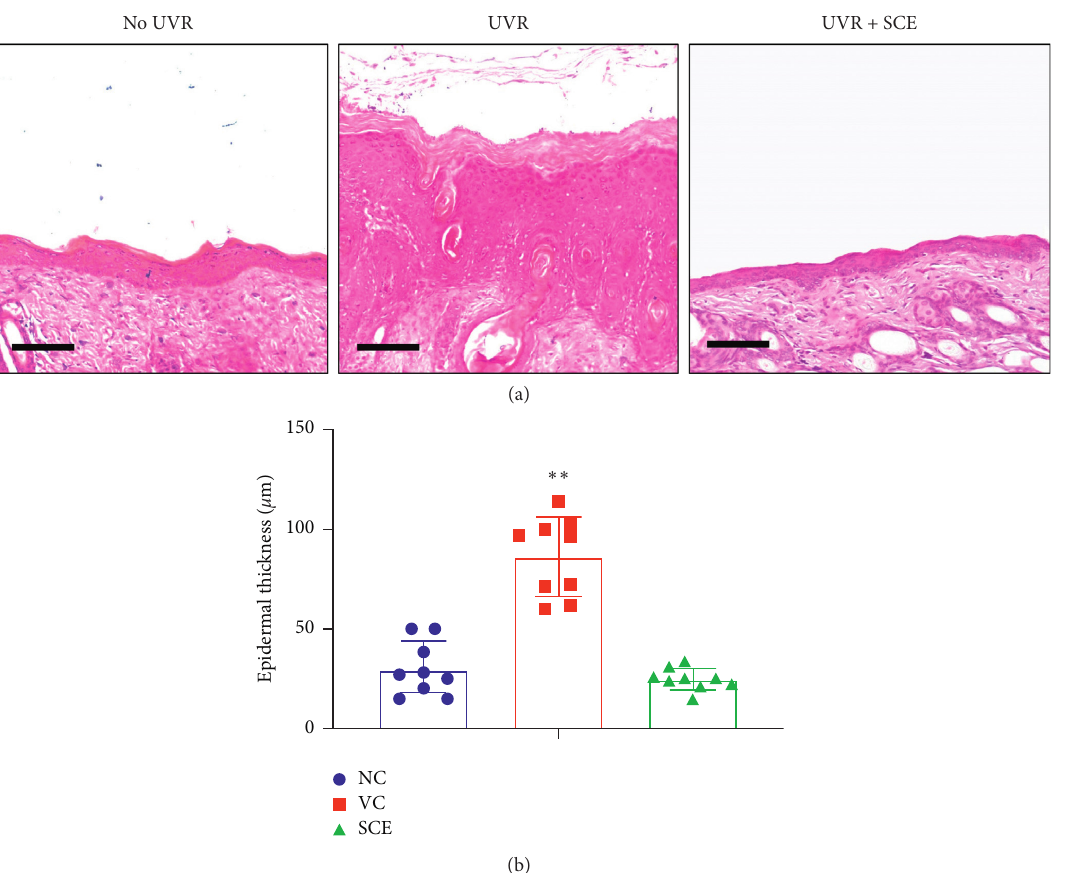
Figure 4: Evaluation of epidermal hyperplasia of the mice dorsal skin due to UV-A irradiation. (a) Hematoxylin and eosin (H&E) staining of UV-A-irradiated mice dorsal skin. (b) Epidermal thickness of the mice skin dorsal area, analyzed with Zeiss Axiovision software. Scale: 50 um. ∗∗ Highly significantly different compared to control (NC); P < 0 .